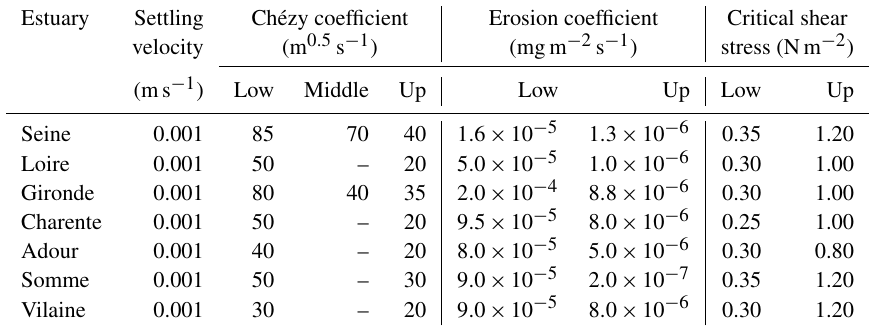
Table 5. Parameter settings related to salinity and sediment and their values along the estuaries (low, middle, and upstream parts). Estuary